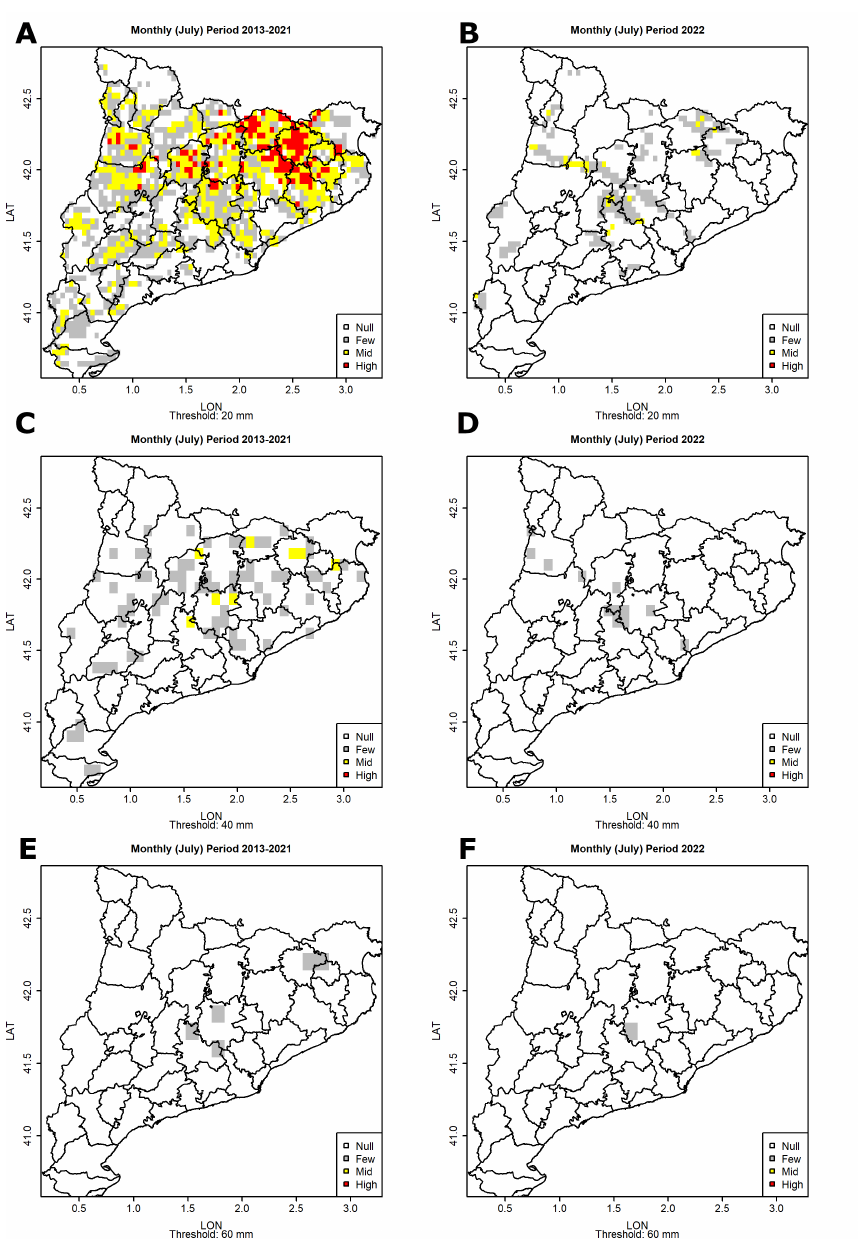
Figure 6. ( A – F ) Same as Figure 4, but for the July monthly